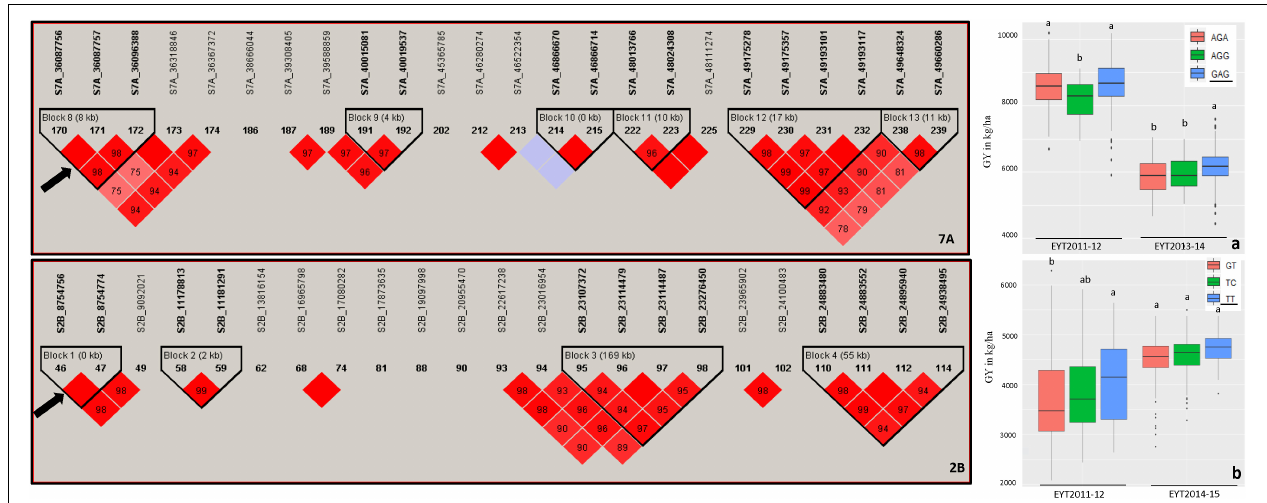
FIGURE 1 | Partial haplotype maps of chromosomes 7A and 2B showing haplotype blocks HB19.8 and HB5.1 (indicated with an arrow) associated with GY in B-5IR and B-2IR environments, respectively (left part of figure). The numbers inside the diamonds are the r 2 values between SNPs on a scale of 0 to 100%. Allelic effects of the haplotypes in blocks HB19.8 (a) and HB5.1 (b) on grain yield ( Y axis in kg/ha) are shown on the right. The favorable haplotypes are underscored based on the highest mean.